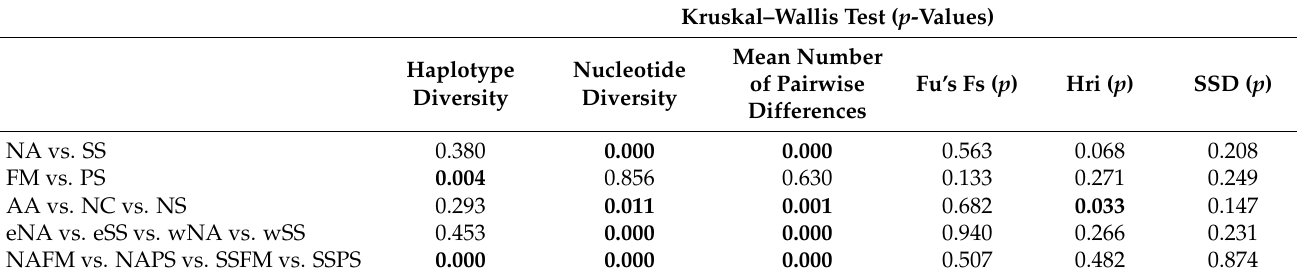
Table 1. Kruskal–Wallis one-way test ( p -values) of differences in average diversity indices and demographic parameters among specified groups of